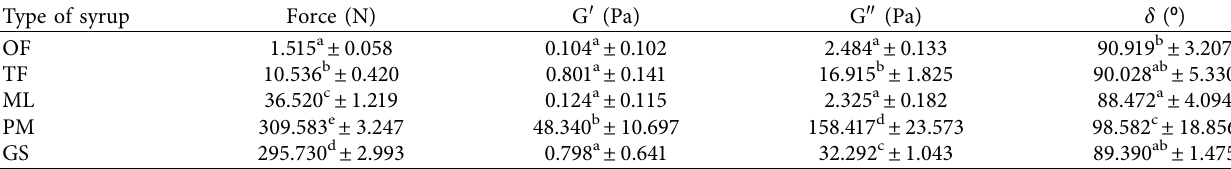
Table 3: Values of back extrusion force, G ′ , G ″ modulus, and δ ( ° ) of tested syrups used in high-protein bars. Type of